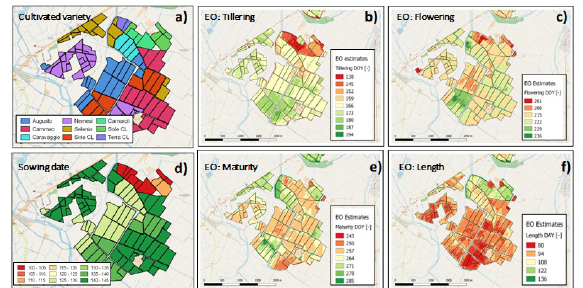
Figure 4. Examples of Phenological estimates at field level for a case study rice farm in Lomellina (North of Italy, Pavia province, latitude 45°15’ N ± 1.5’, longitude 8° 34’ E ± 2’, 112